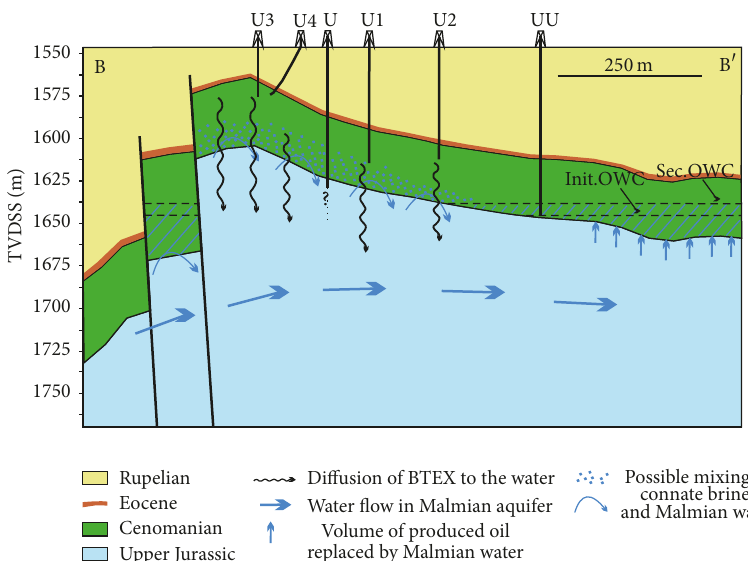
Figure8:SimplifiedcrosssectionoftheoilfieldandlocationofU1–U4samples.WellUisusedforreinjectionofthermalwaterproducedfrom Malmian (Upper Jurassic) horizon by a well located 3km west of the section. Well UU is used as reinjector for reservoir brines coproduced with oil. Init. OWC: initial oil-water-contact at the beginning of oil production. Sec. OWC: secondary oil-water-contact estimated after 40 years of production. TVDSS: true vertical depth